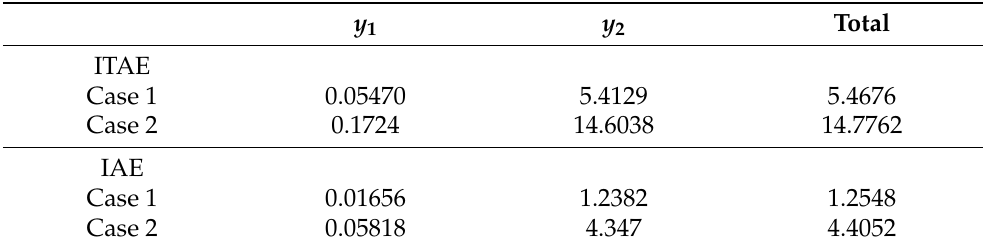
Table 5. The performance indices for the Van de Vusse